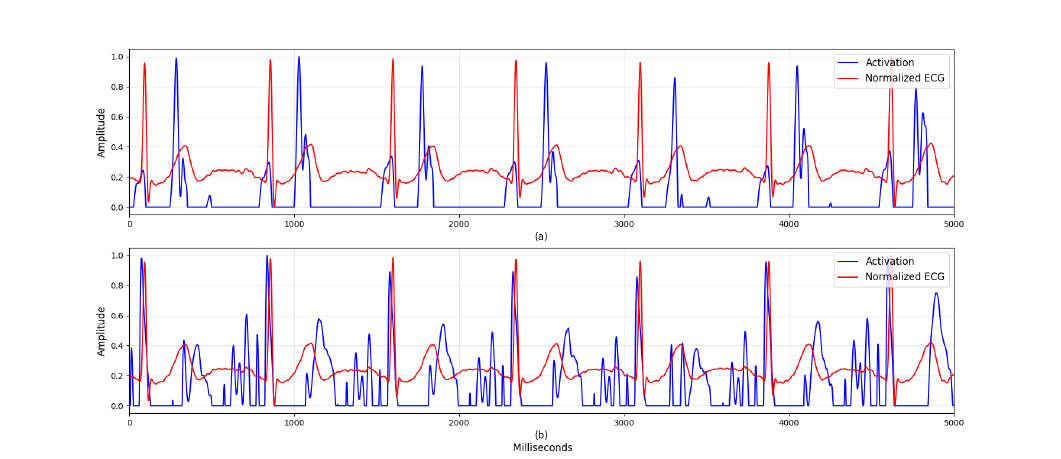
Figure 4. The activations on the first ReLU of electrocardiogram (ECG) signal. To easily see which signal patterns were activated, the activations and the first batch-normalization layer’s output were normalized with MinMax Scaler having a range from 0 to 1. The blue line indicates the activations and the red line indicates the output. Activations around ( a ) ECG Q and T’s ascending waveform and ( b ) ECG QRS and T’s descending